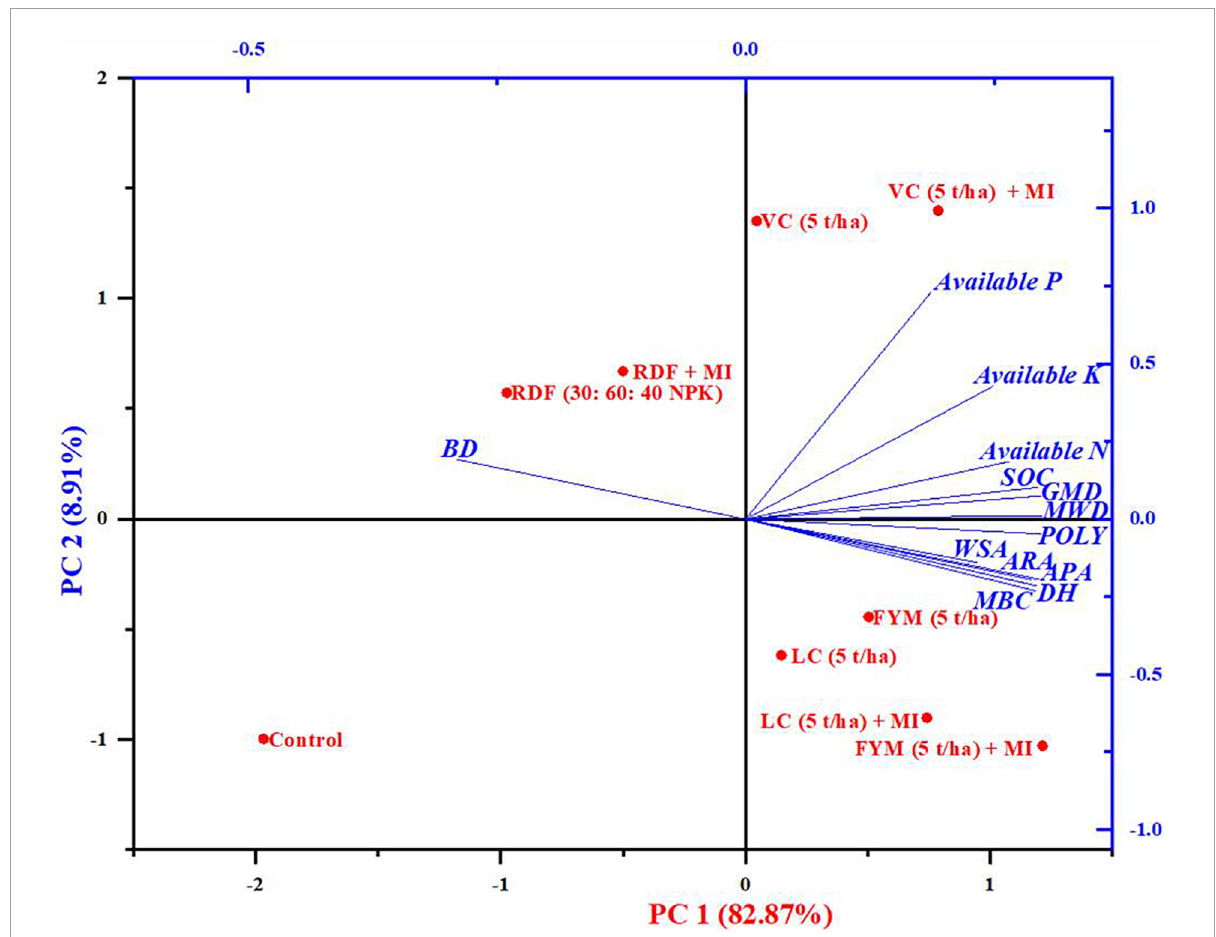
FIGURE4 The two-dimensional graphical biplot showing both the loading and the scoreplot of soil physical, chemical, and biological properties.